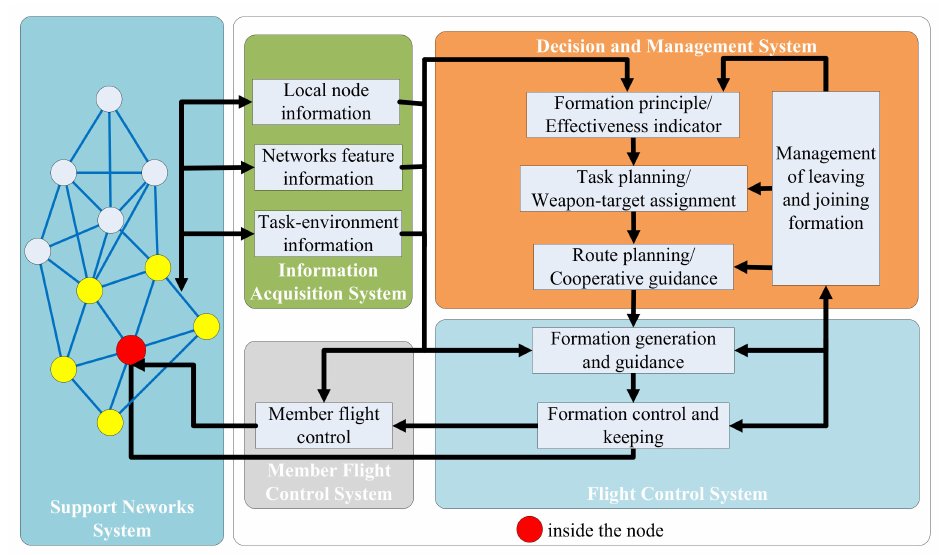
Figure 1. Structure of the unmanned vehicle collaboration formation system.